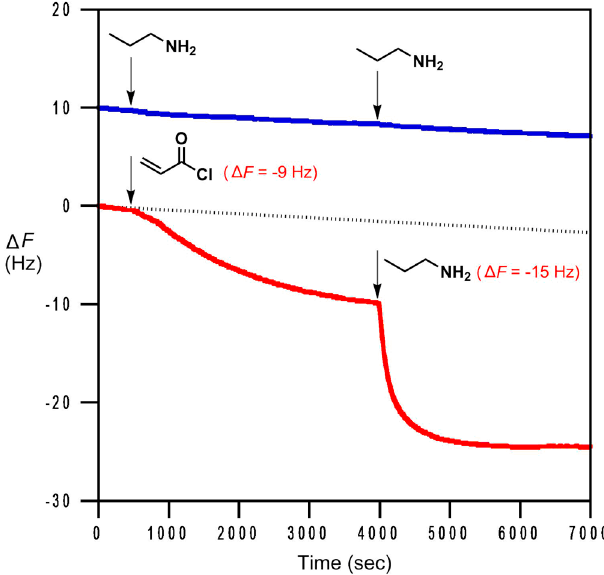
Figure 12. Detection of acryloyl chloride and propylamine (503 ppb each) was achieved by AIL9 . Acryloyl chloride was injected at 500 s while propylamine was at 4000 s. The QCM sensorgrams for two injections of propylamine gas purposely shifted vertically by 10 Hz for clarity [112].